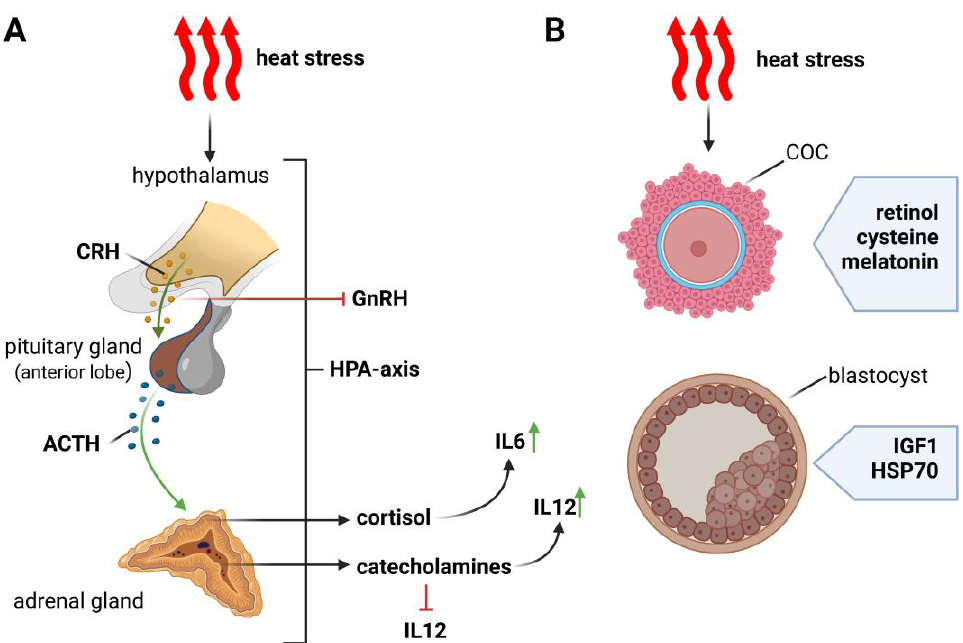
Figure 4. Scheme showing the impact of heat stress on the hypothalamus–pituitary–adrenal (HPA) axis ( A ), and how to counteract the effect of heat stress on the cumulus–oocyte complex (COC) and the blastocyst ( B ).